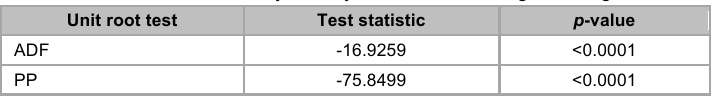
Unit root tests for stationarity of daily USD/ZAR exchange rate log-returns Unit root test Test